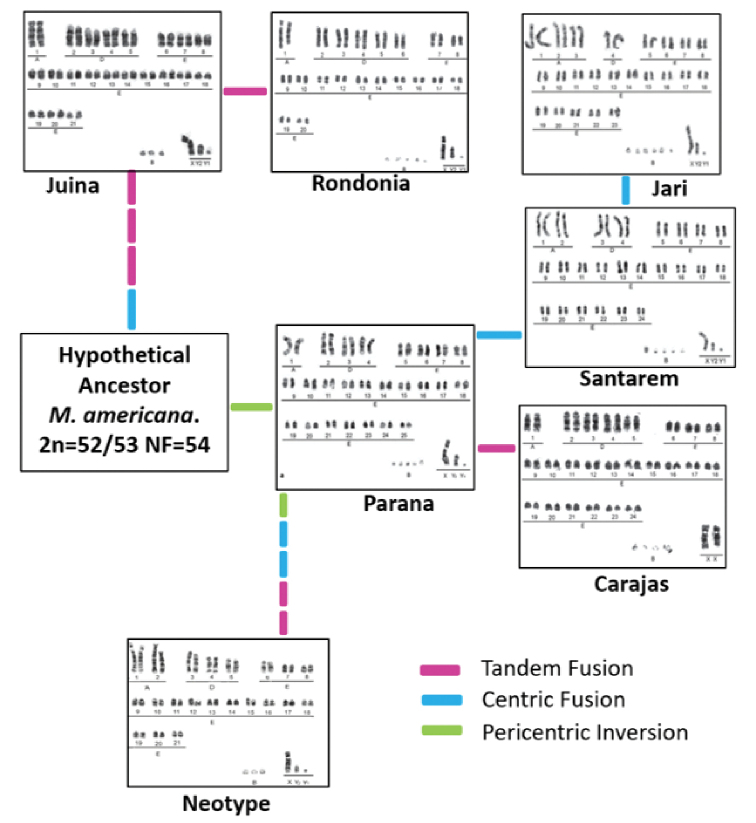
Chromosomal evolution showing the relationships of the six cytotypes compared to the M.
americana neotype. Juine: 2n = 44/45; Rondônia: 2n = 42/43; Santarém: 2n = 50/51; Jari: 2n = 48/49; Paraná: 2n = 52/53; Carajás: 2n = 50/51; Neotype: 2n = 45 (Adapted from Abril et al. 2010).